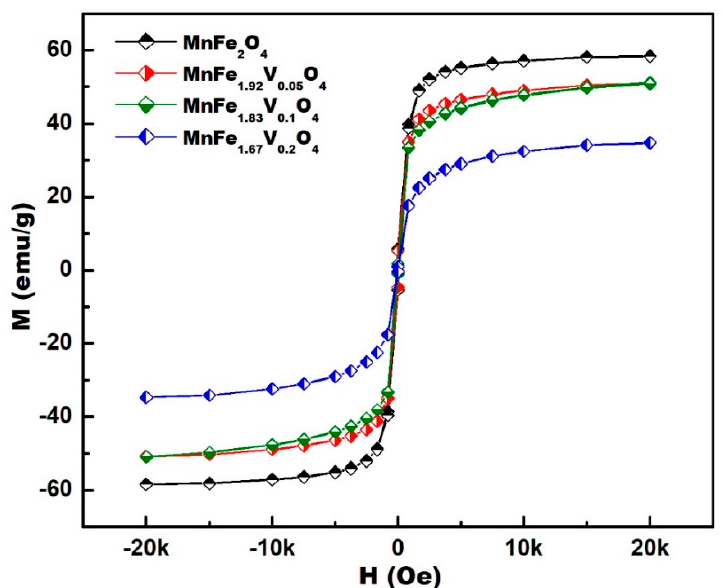
Figure 7 . H-M hysteresis loops of MnFe 2-1.67x V x O 4 spinel ferrite system hydrothermally synthesized Figure 7. H-M hysteresis loops of MnFe 2 − 1.67x V x O 4 spinel ferrite system hydrothermally synthesized at 180 °C. at 180 ◦ C.